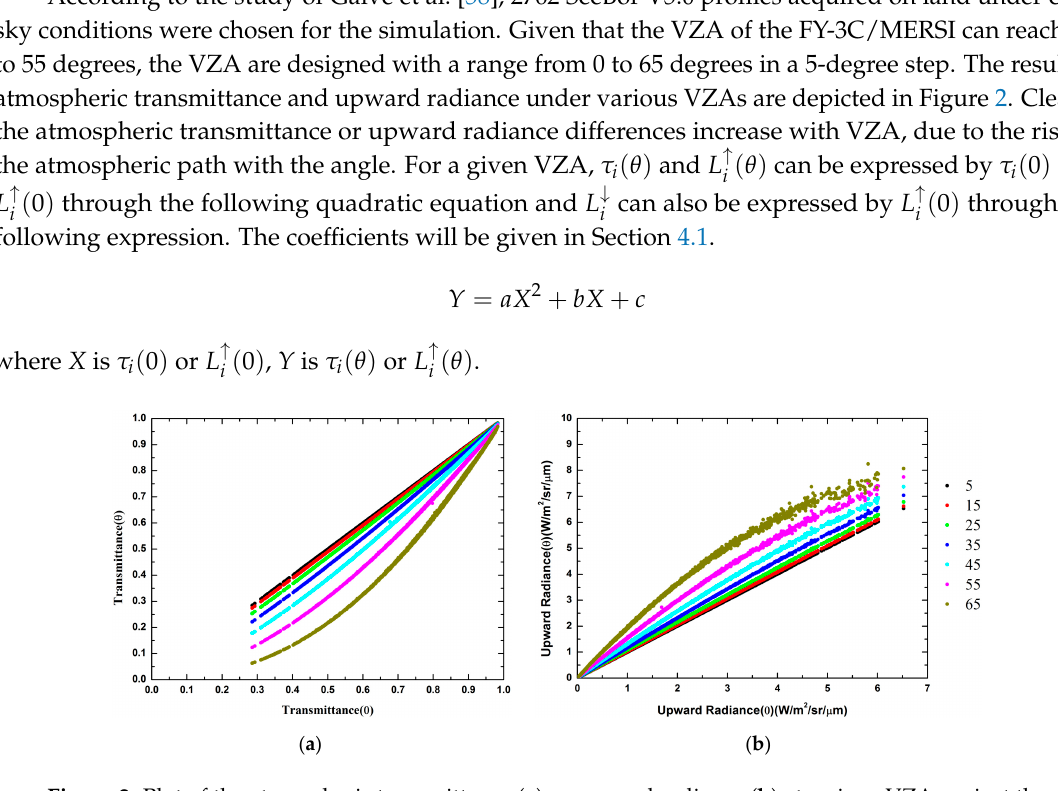
Figure 2. Plot of the atmospheric transmittance ( a ) or upward radiance ( b ) at a given VZA against the atmospheric transmittance or upward radiance at nadir view. atmospheric transmittance or upward radiance at nadir